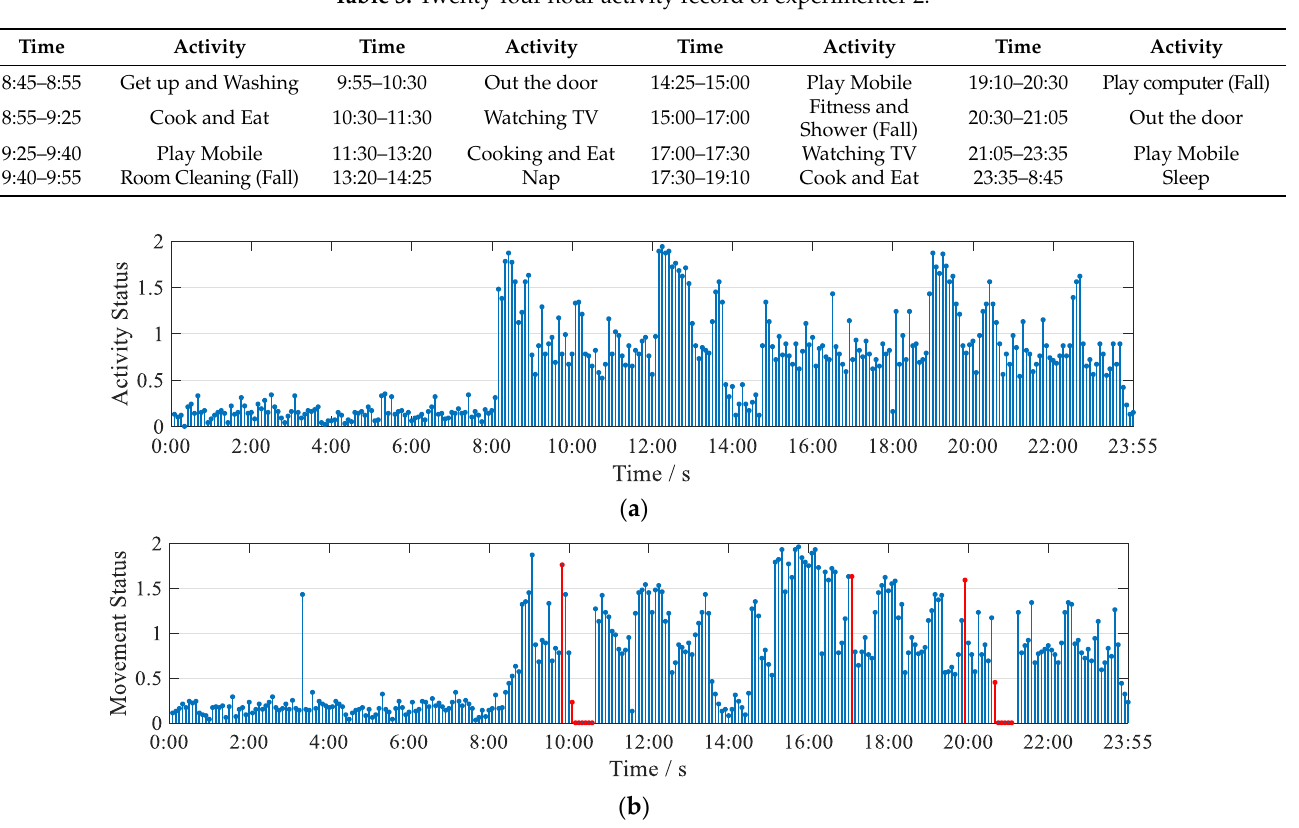
Figure 13. Activity status map: ( a ) experimenter 1 24 h activity status map; ( b ) experimenter 2 24 h activity status map.